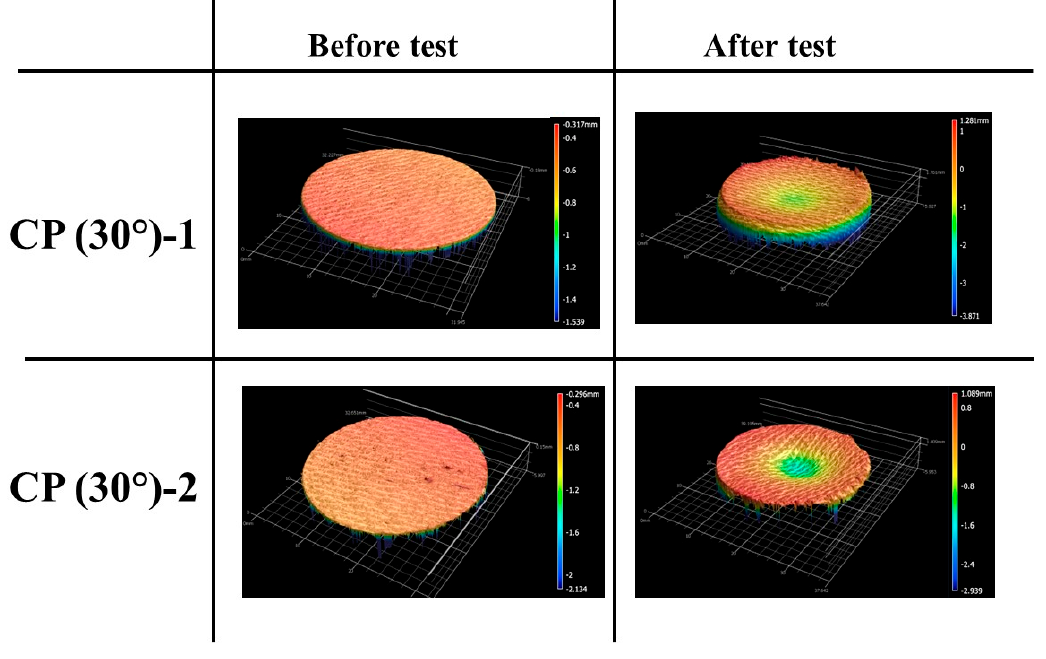
Figure 15. CP (30°)-1 (3.25 MW/m 2 , 60 s) and CP (30°)-2 (6 MW/m 2 , 30 s) exposed surface morphol- ogy changes.